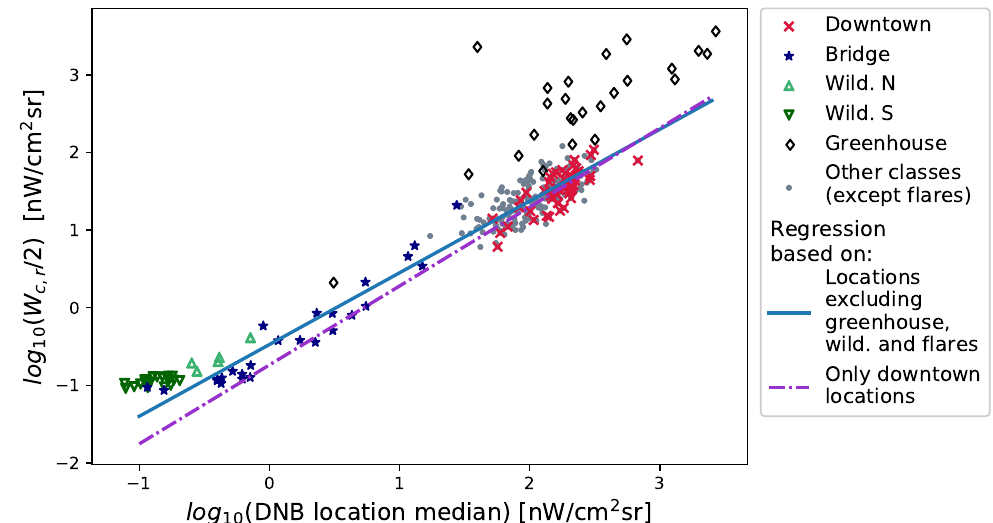
Figure 6. Relationship between the typical month-to-month variation in radiance to the mean radiance for all sites with the exception of flares, plotted on a log–log scale. The lines show linear regressions on the logarithmic